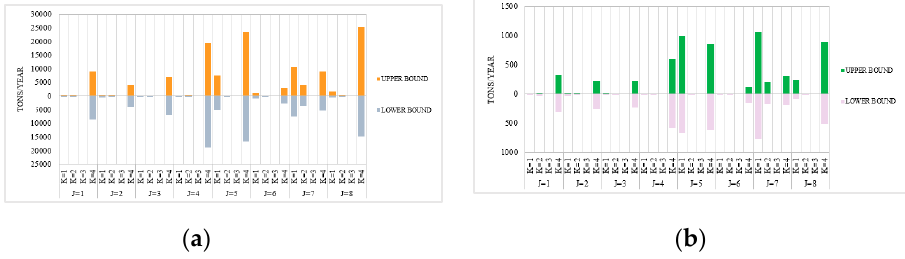
Figure 3. The emissions of COD and ammonia nitrogen from different water use departments in different areas of the Yinma River Basin in the first planning period. ( a ) The emissions of COD in the third planning period; ( b ) The emissions of ammonia nitrogen in the third planning period.